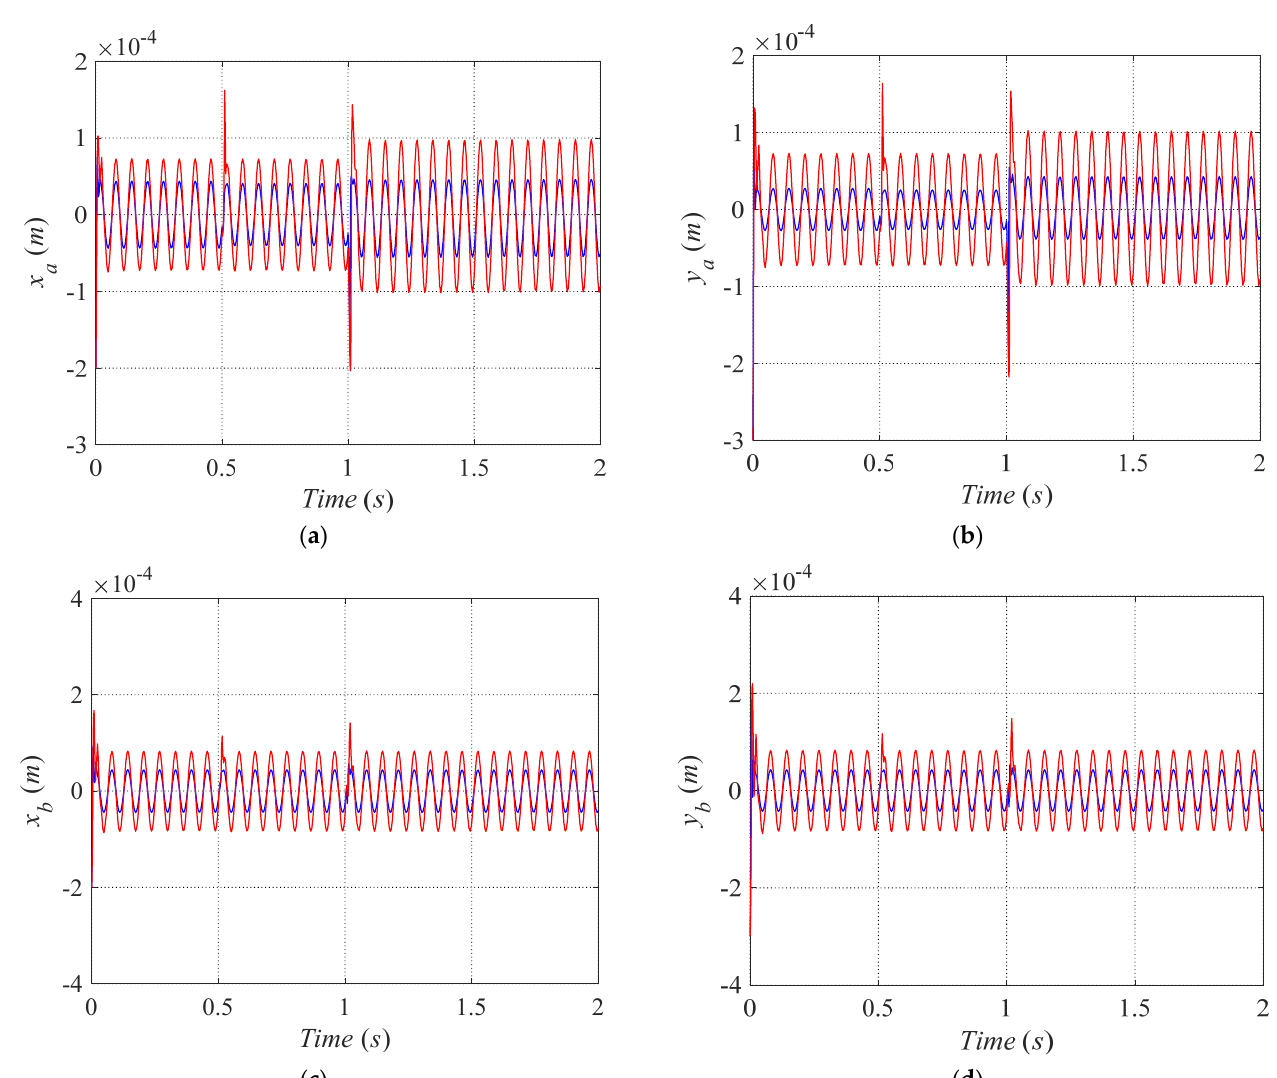
Figure 12. Trajectories of the magnetically-levitated rotor in four degrees of freedom directions under the existing fault- tolerant control by red curve and proposed in this paper by blue curve. The curves of x a , y a, x b and y b are respectively illustrated in ( a – d ) that the sinusoidal disturbance is considered